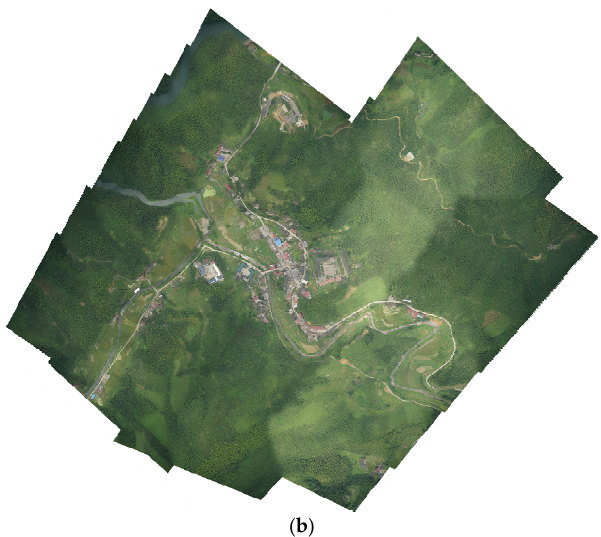
Figure 7. Mosaicking result of Dataset 3: ( a ) mosaicking result via Capel’s method; and ( b ) mosaicking result using the proposed algorithm.